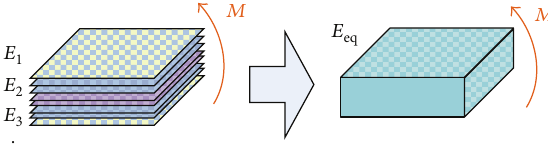
Figure 3: The composite material is stacked in layers of materials with different elastic moduli, and the composite can be regarded as a homogeneous material with an “equivalent” elastic modulus.